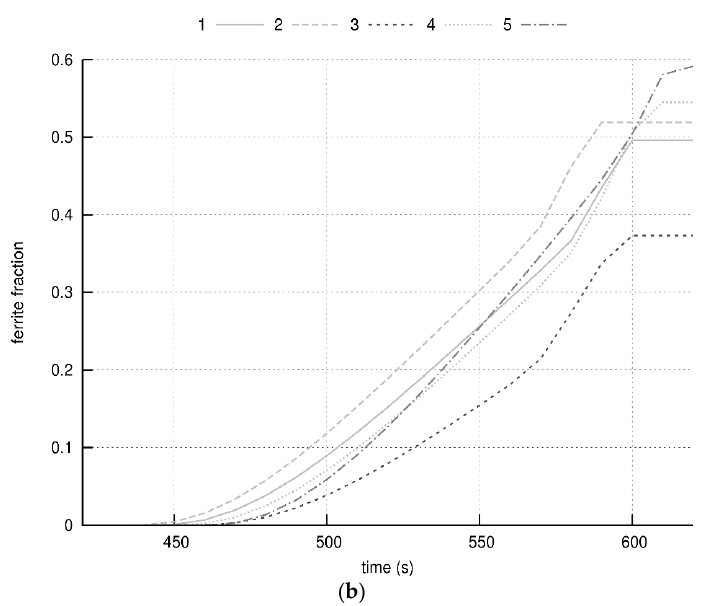
Figure 7. Simulated volume fractions of ( a ) pearlite and ( b ) ferrite as a function of time at each of the five regions.